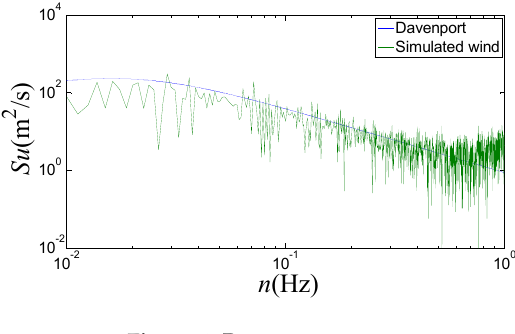
Figure 4. Power spectrum.